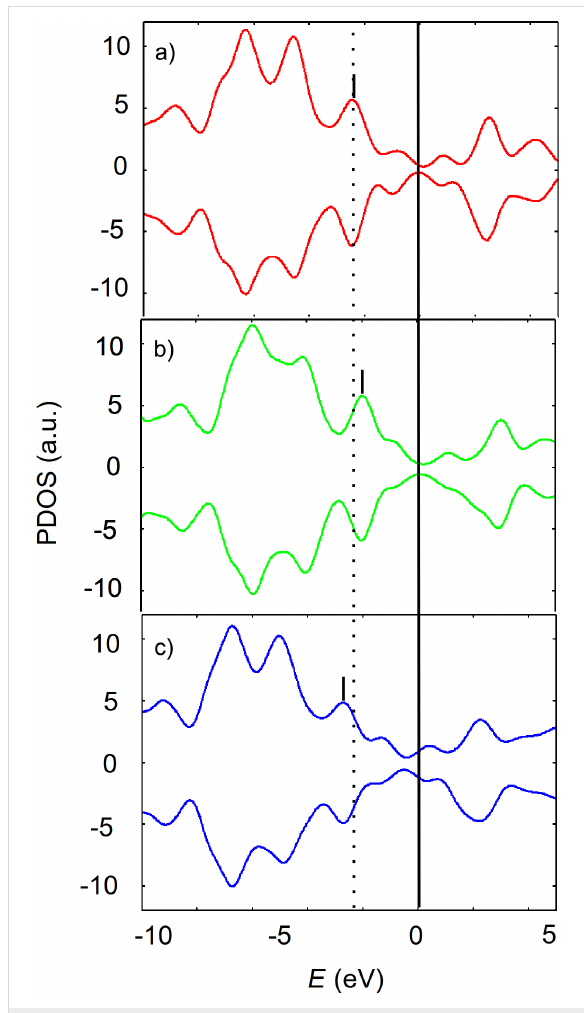
Figure 8: Spin-resolved PDOS of FeTPP. a) free molecule (red), adsorbed on fcc site of b) Au(111) (green), c) on Ag(111) (blue). The shift of PDOS on Cu(111) is similar to that on